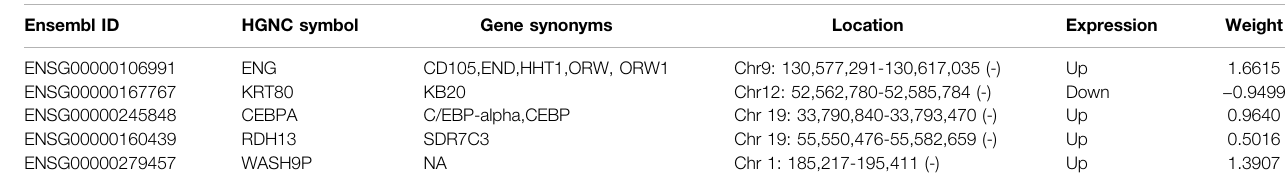
TABLE 1 | Detailed information of fi ve biomarkers in the signature. Ensembl